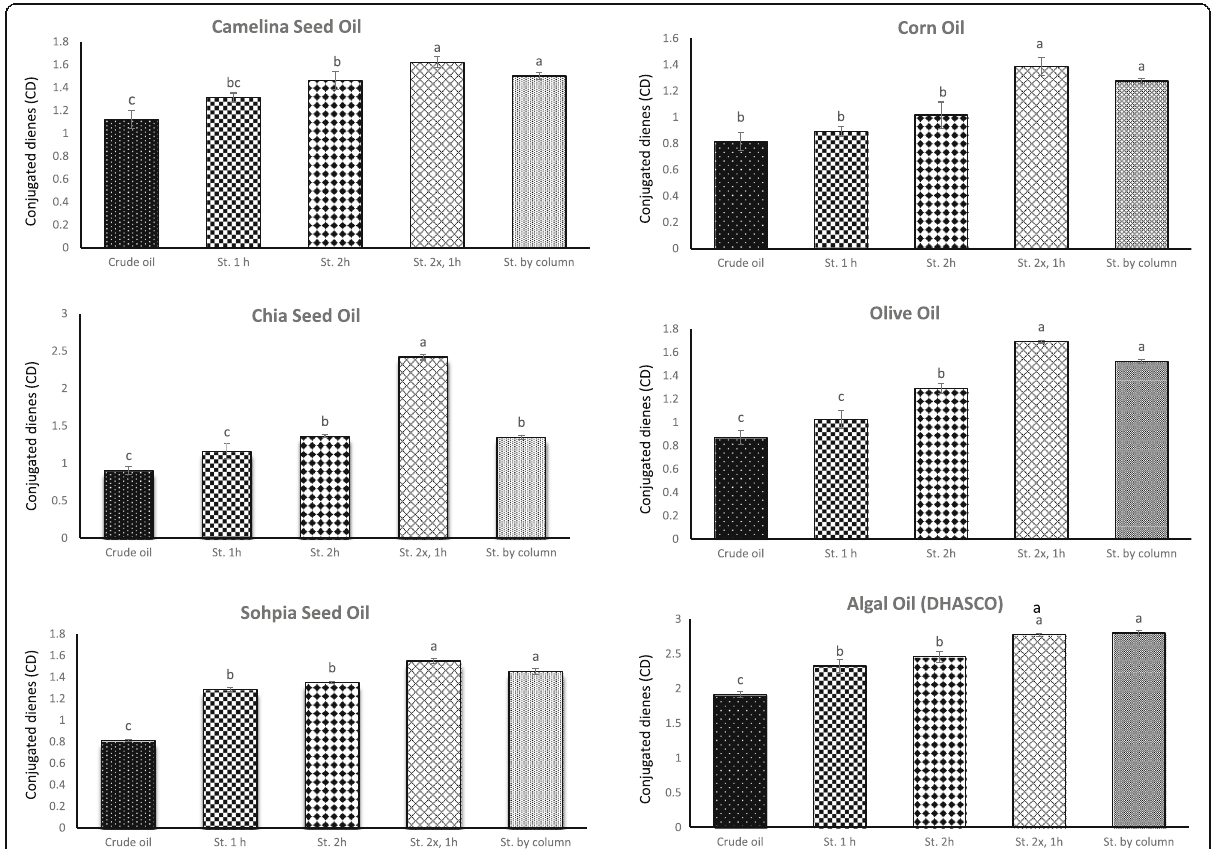
Fig. 2 Conjugated dienes of stripped and non-stripped camelina seed oil, sophis seed oil, chia seed oil, corn oil, olive oil, and DHASCO. (crude oil, non-stripped oil; St. 1 h, simplyfied stripped oil 1 h; St. 2 h, simplyfied stripped oil 2 h; St. 2 × 1 h, simplyfied stripped oil twice for 1 h; and St. by column, column stripped